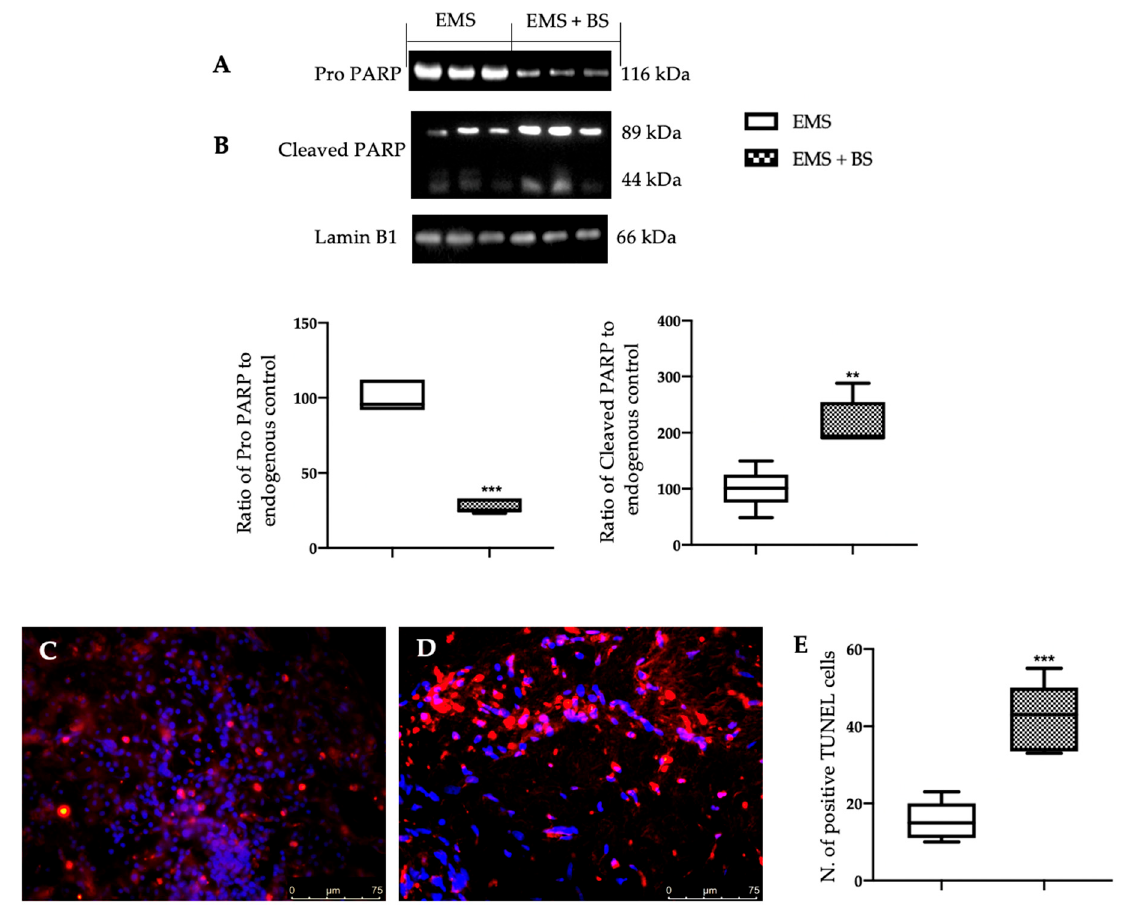
Figure 6. Analysis of the effect of oral BS administration on apoptosis: Western blot analysis of: Pro PARP ( A ), cleaved PARP ( B ) expression; TUNEL staining (magnification 40×): EMS ( C ), EMS + BS ( D ), number of TUNEL positive cells ( E ). For the analyses, n = 5 animals from each group were employed. A p -value of less than 0.05 was considered significant. ** p < 0.01 vs. control, *** p < 0.001 vs. control.